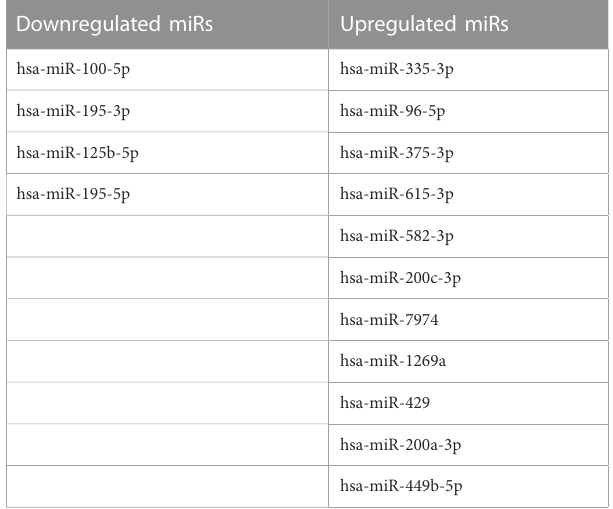
TABLE 7 Differentially expressed miRNAs in HGSOCs. Downregulated miRs